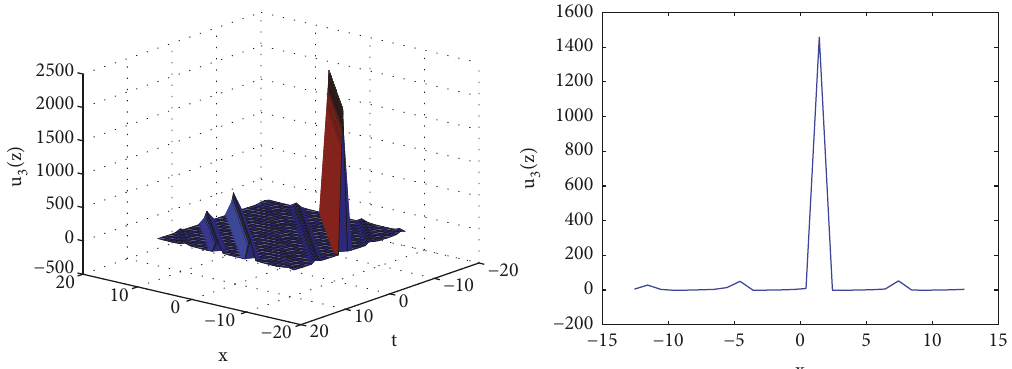
Figure 3: The 3D and 2D surfaces of 𝑢 3 (𝑧) by considering the values 𝛾 = 3 , 𝜇 = 2.5 , 𝑘 = 1 , 𝐿 = 1 , 𝜆 = −32 , 𝑦 = 0 , 𝑎 = 1 , and 𝑡 = 0 for the 2D graphic.